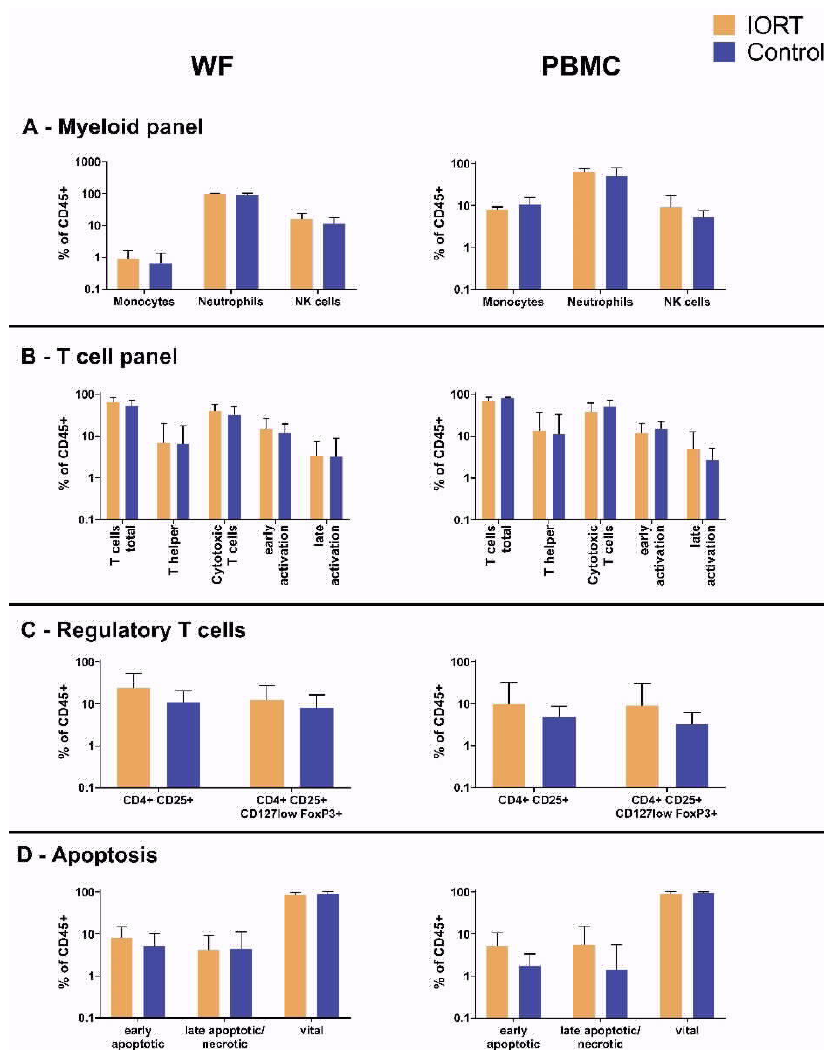
Figure 1. Absolute cell counts of myeloid ( A ), lymphoid ( B ), Treg ( C ) and apoptotic ( D ) cells. Indicated values: mean ± standard deviation, statistical analysis by double sided t-test. Myeloid analysis: N (WF) = 31 (IORT 19, control 12); N (PBMC) = 17 (IORT 11, control 6) Lymphoid analysis: N (WF) = 33 (IORT 21, control 12); N (PBMC) = 22 (IORT 15, control 7) Treg analysis: N (WF) = 24 (IORT 14, control 10); N (PBMC) = 16 (IORT 11, control 5) Annexin staining: N (WF) = 30 (IORT 20, control 10); N (PBMC) = 21 (IORT 14, control 7). (For PBMC, some patients did not consent to an additional blood sampling and for some patients, cell numbers were insufficient for analysis.).